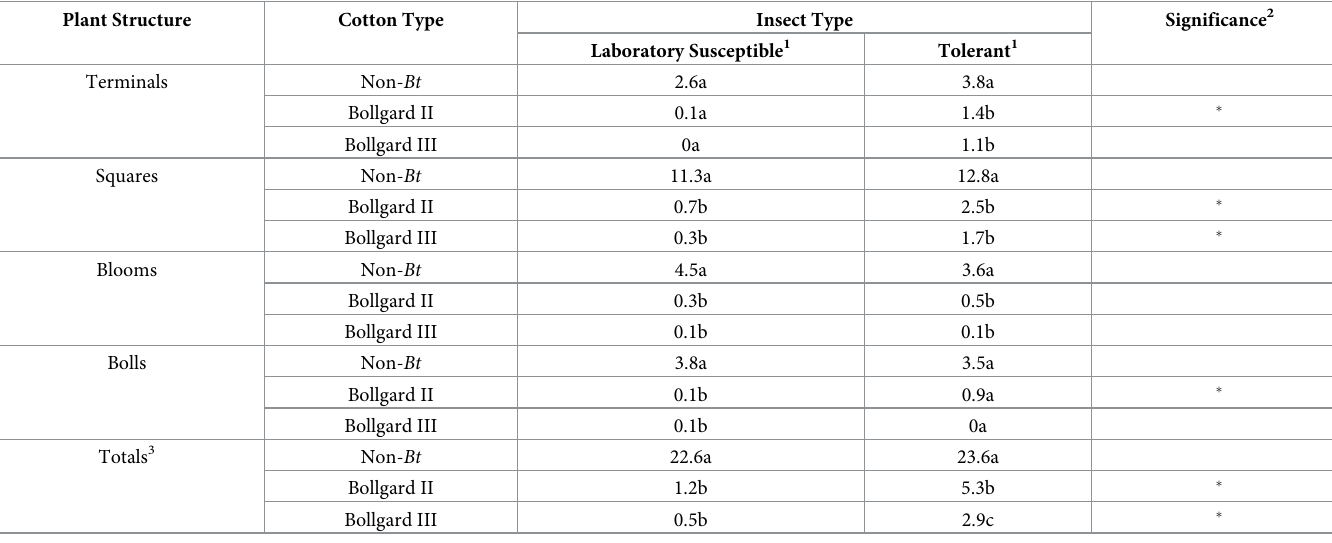
Table 2. Cumulative H . zea larvae in terminals, squares, bolls, and blooms per 25 plants at final rating period. Plant